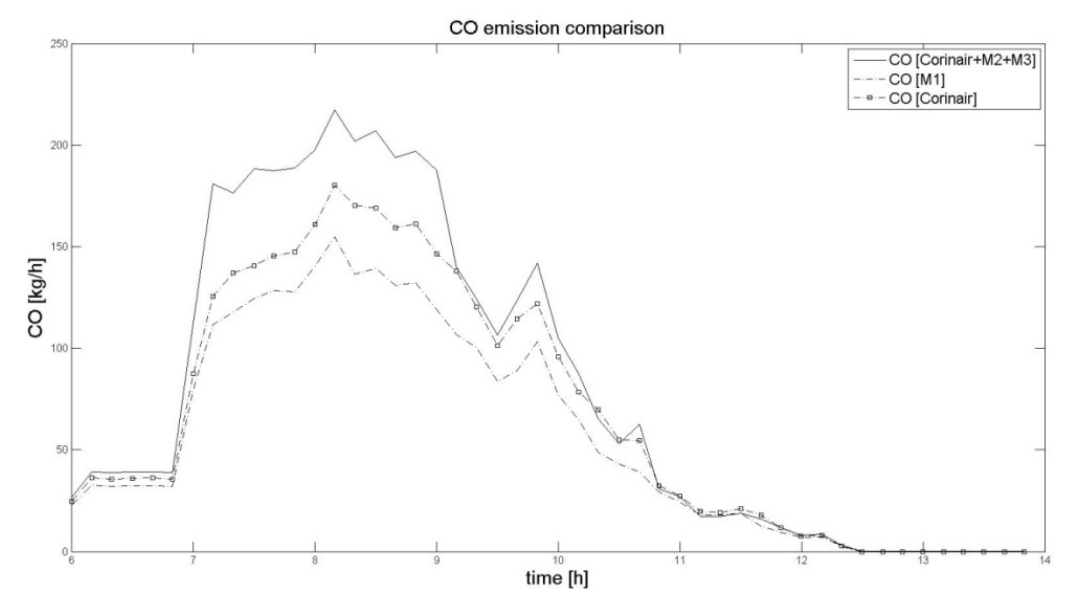
Figure 8. CO distribution with the three methods.